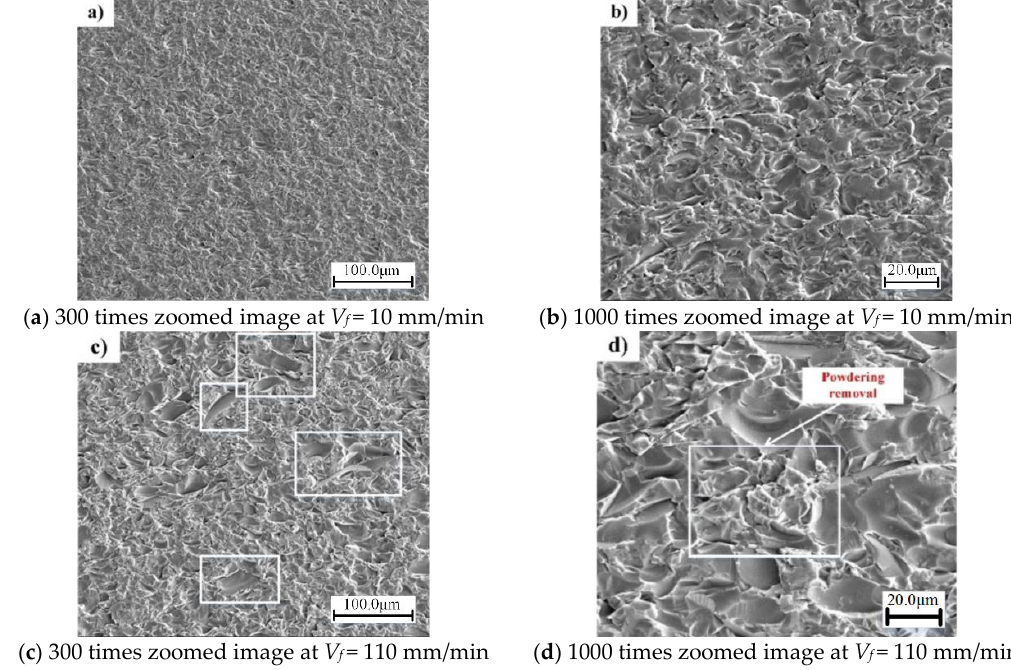
Figure 4. Machined surface morphologies of optical glass material at different feed rate.